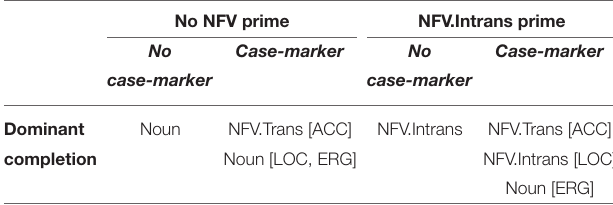
TABLE 11 | Dominant completions with the Genetive case-marker across all the sentence completion studies for various conditions. NFV, non-finite